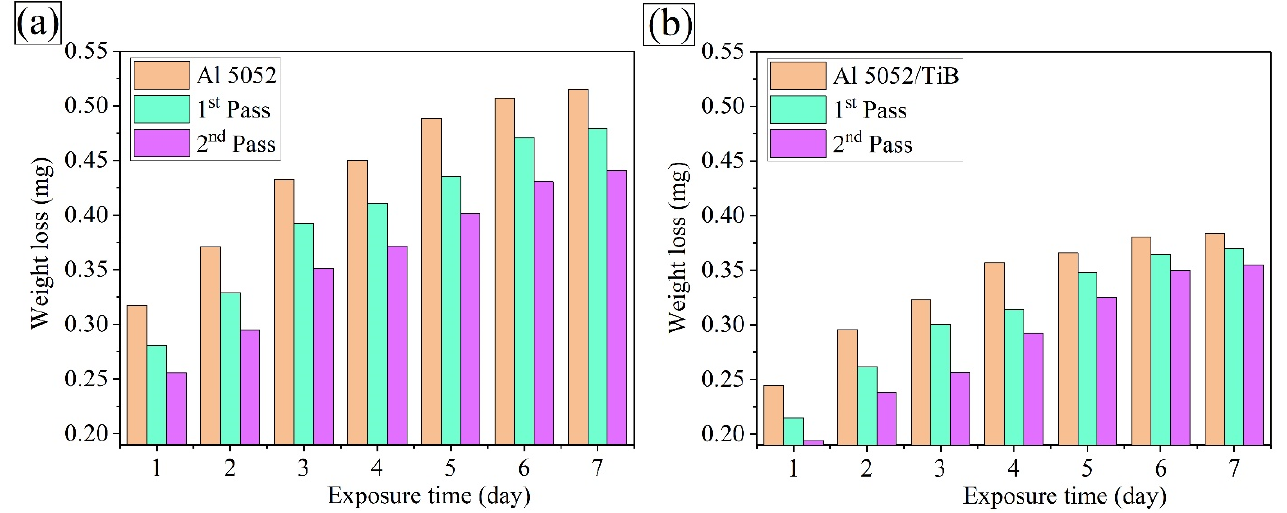
Figure 14. Weight loss of the investigated samples (a) Al 5052 and (b) Al 5052/TiB.